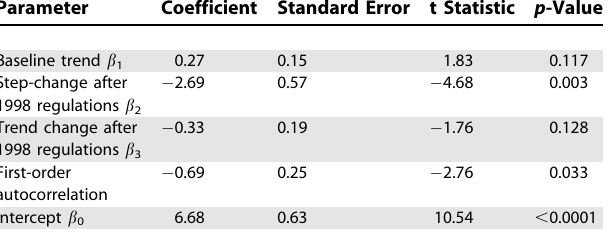
Table 2. Interrupted Time-Series Regression Analysis of Age- Standardised Mortality Rates for Paracetamol Poisoning, Adjusted for First-Order Autocorrelation Parameter Coefficient Standard Error t Statistic p -Value